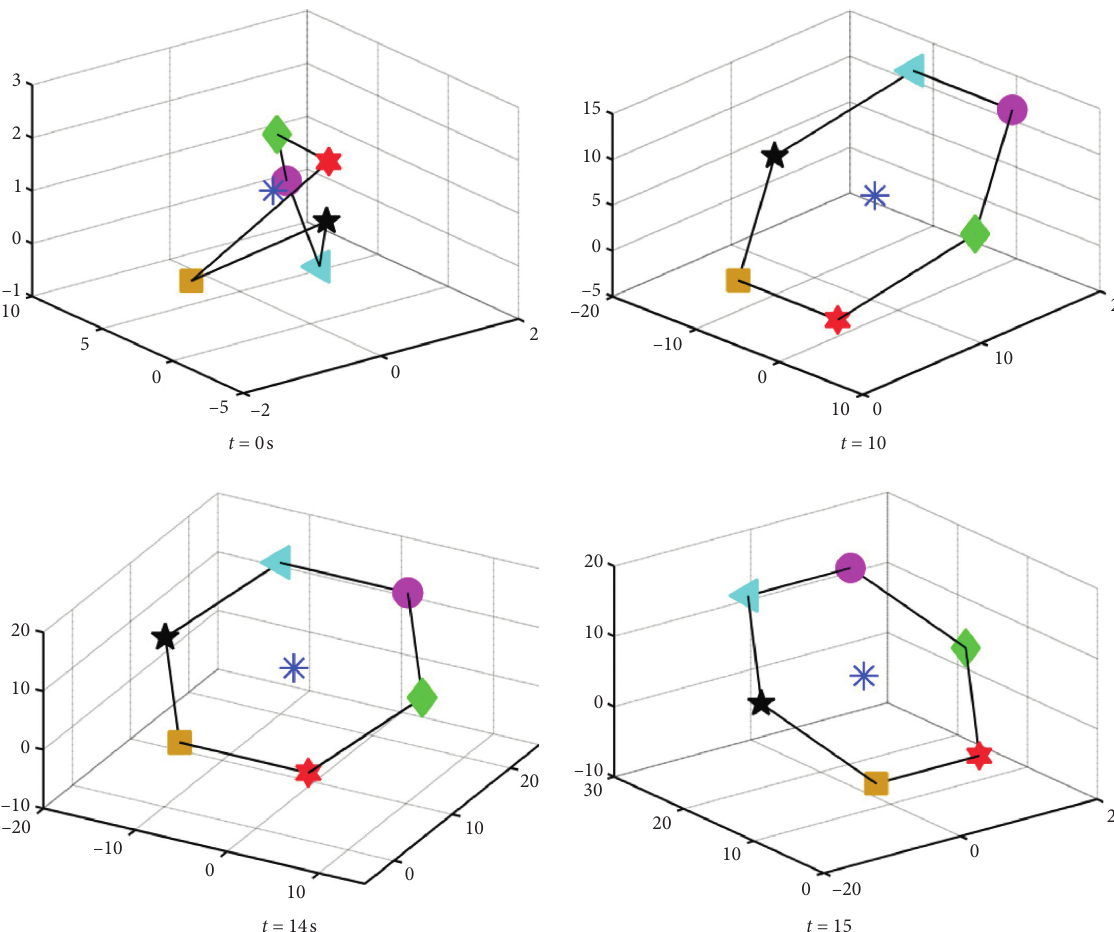
Figure 11: State snapshots of all agents at different times for the leader-following case. (a) t � 0 s. (b) t � 12 s. (c) t � 14 s. (d) t � 15 s.